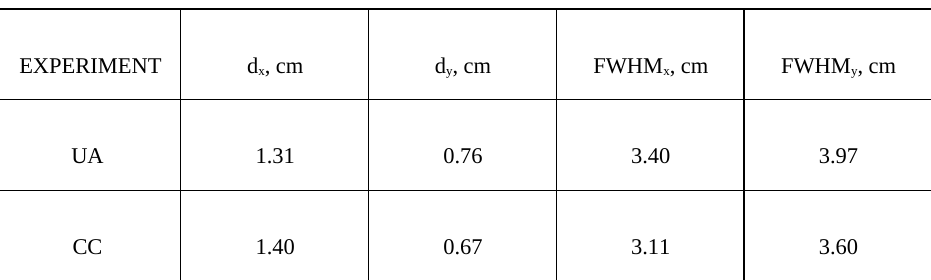
CC 1.40 0.67 3.11